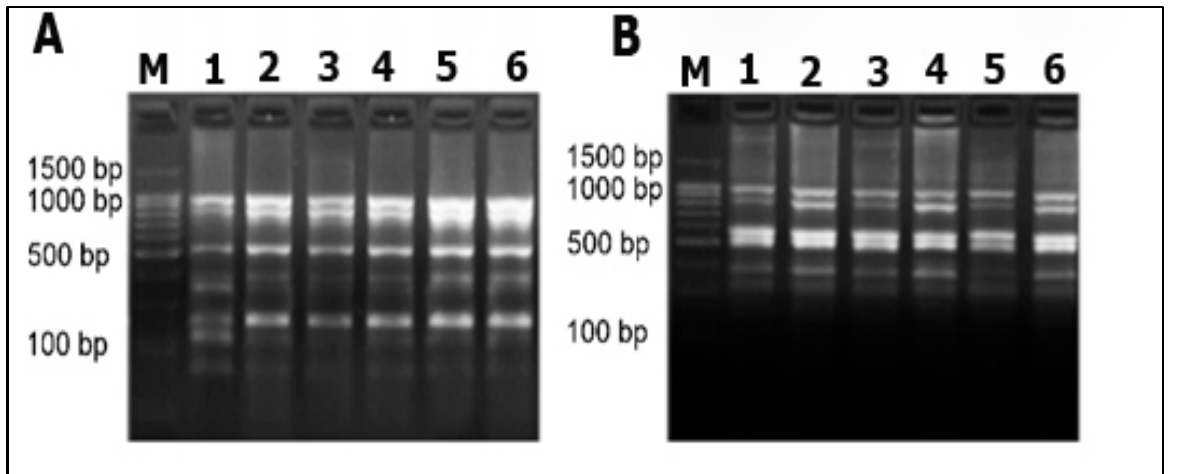
Figure 2. The 1.5% agarose gel electrophoresis of representative ( A ) BOX and ( B ) ERIC PCR patterns. M—DNA ladder; 1–2— B. mojavensis PS17(I); 3–4— B. mojavensis PS17(II); 5–6—the original strain of B. mojavensis PS17.